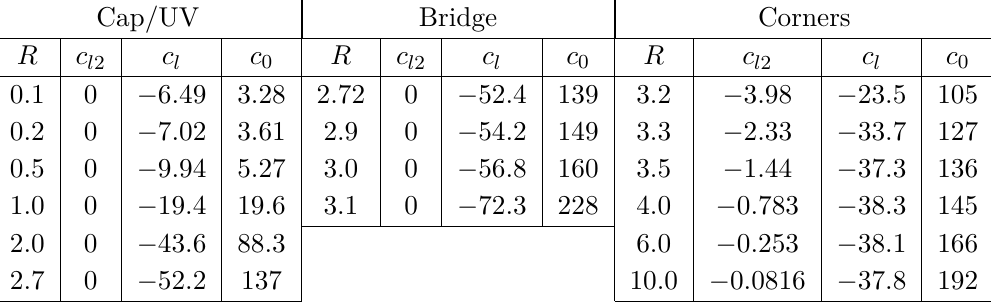
Table 3. Entropy coefficients defined in eq. (4.9). The range of R values is divided into three intervals corresponding to the cap, bridge, and corner